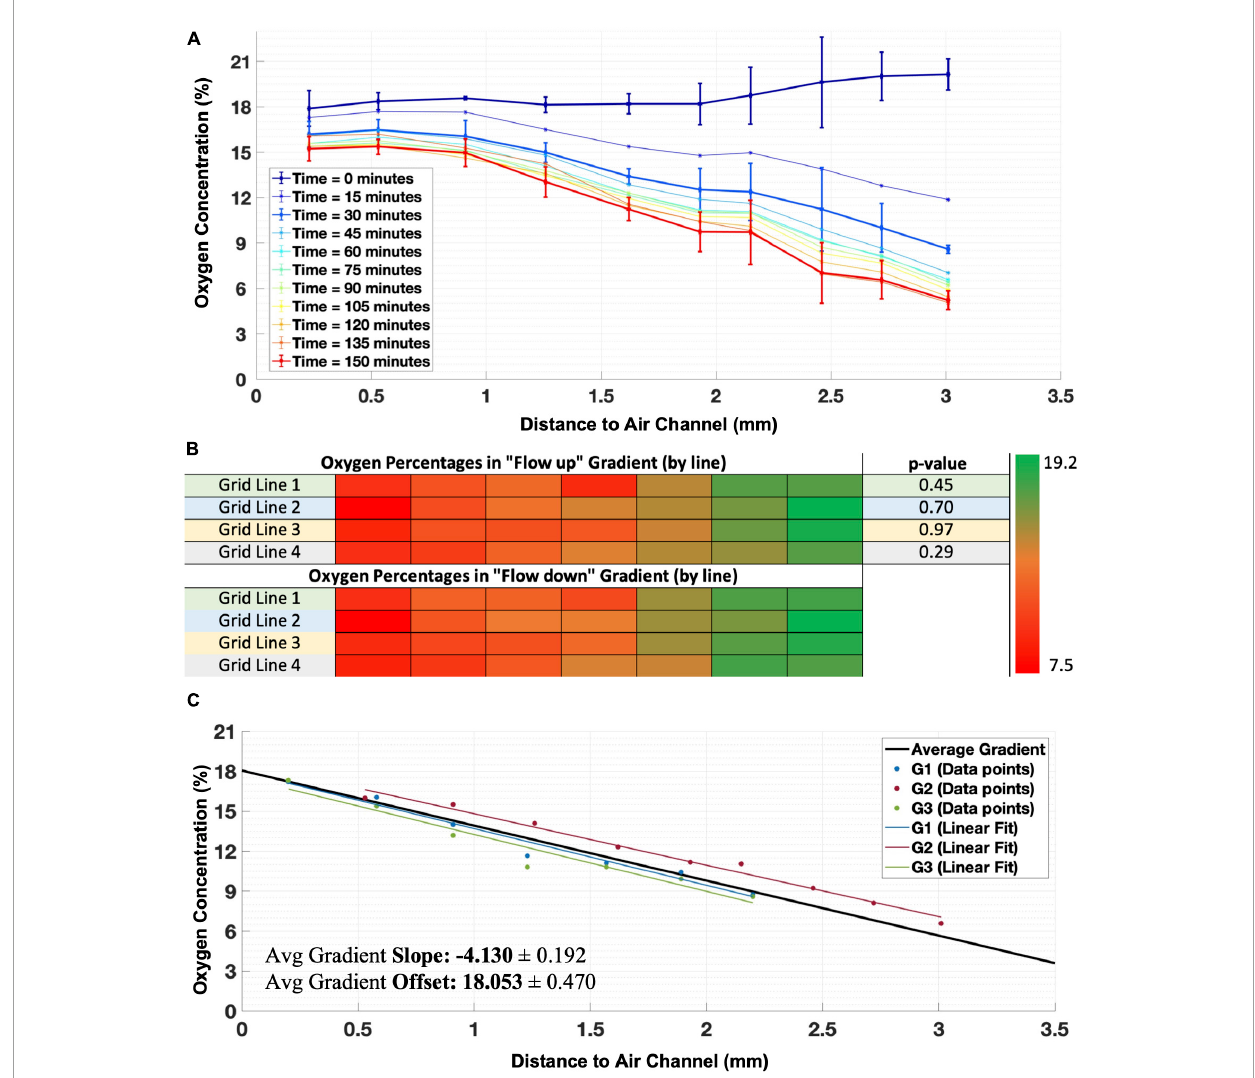
FIGURE3 Establishment of the oxygen gradient. (A) Example of time course of establishment of the oxygen gradient in one illustrative experiment, showing stability and linearity of the gradient after 30 min. Error bars indicate SD and refer to differences between sensors in the same column perpendicular to the gradient ( n = 4 sensors per column). For clarity error bars are shown only for t = 0, t = 30 min, and t = 150 min, other curves had error bars of comparable magnitude. (B) Changing the direction of flow through the inserts did not significantly change the readout values of sensors in lines of the grid (direction of the gradient), showing that there was no transverse component. (C) Real gradients observed in three experiments (shown for the measurable length using the grid of sensors in each experiment) which were averaged and extrapolated for the full gap between the inserts (Average Gradient, traced in black) to obtain the mean slope and offset for the generalization of the oxygen gradient produced by the generator.